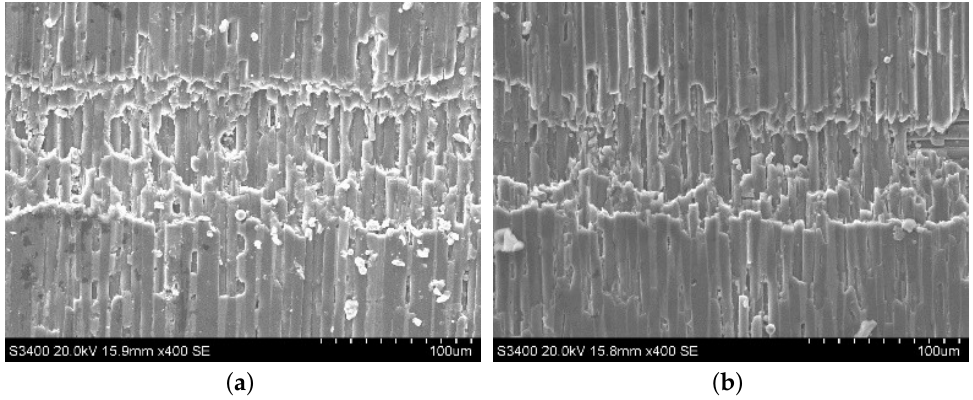
Figure 9. Typical morphologies after cutting C/SiC composites at 90 ◦ . ( a ) is ordinary cutting and ( b ) is ultrasound-assisted